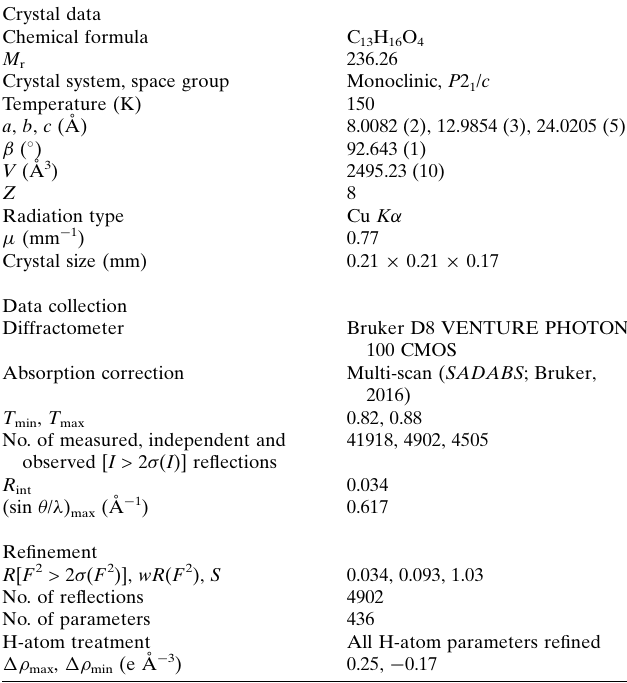
Table 1 Hydrogen-bond geometry (A˚ , (cid:4)